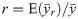
For the simulated population, bias index of the sample mean as a function of πm and πz.Contour levels for the bias index r=E(y¯r)/y¯ based on 100 000 simulations of the nonresponse mechanism, for πm = 0(0.05)0.9 and πz = 0(0.05)0.9. The contour level for r = 1 is confounded with the axes (πz = 0 and πm = 0). Details in the text.